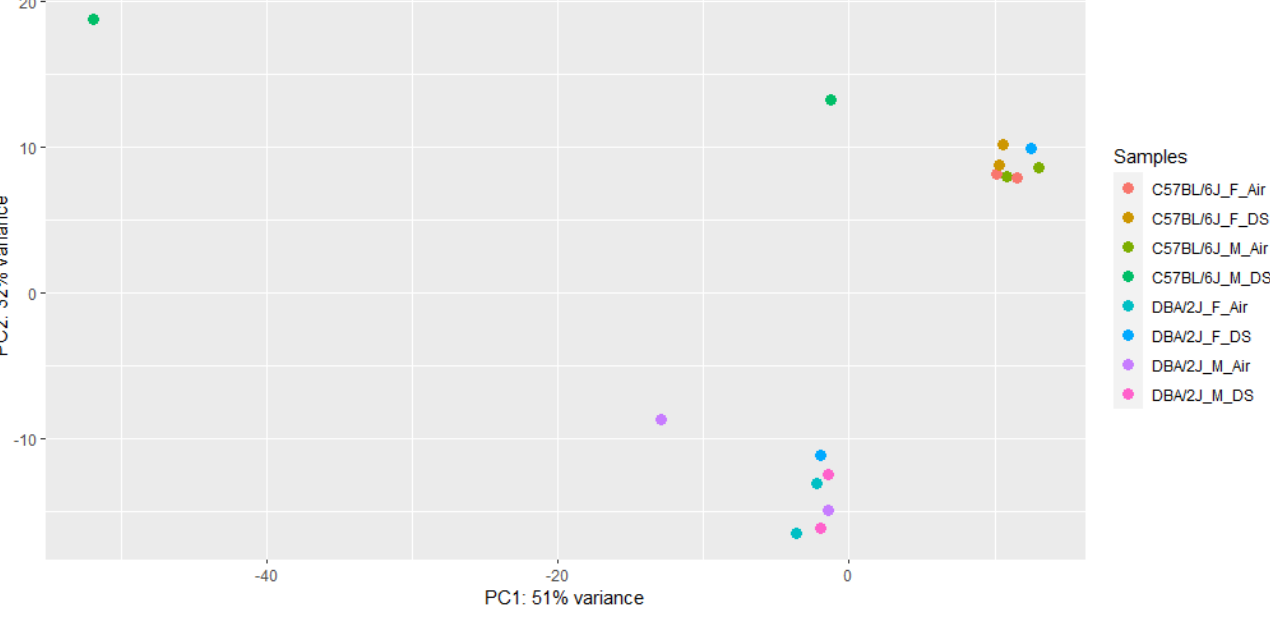
Figure 3. PCA plot of RNA-seq data, with individuals colored by strain (C57BL/6J or DBA/2J), sex (M or F), and treatment (DS or Air) combination. Note the one outlier sample that lies far to the top left of the figure, and so was removed from downstream analyses.